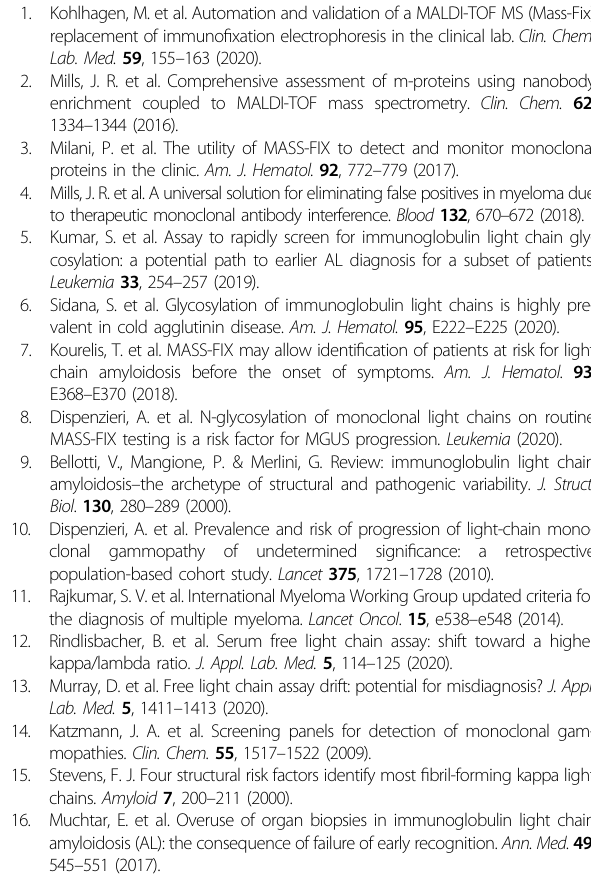
of amyloid fi brils, making LC-bound carbohydrate moi- Table 2 Patients with LC N-glycosylation evaluated for